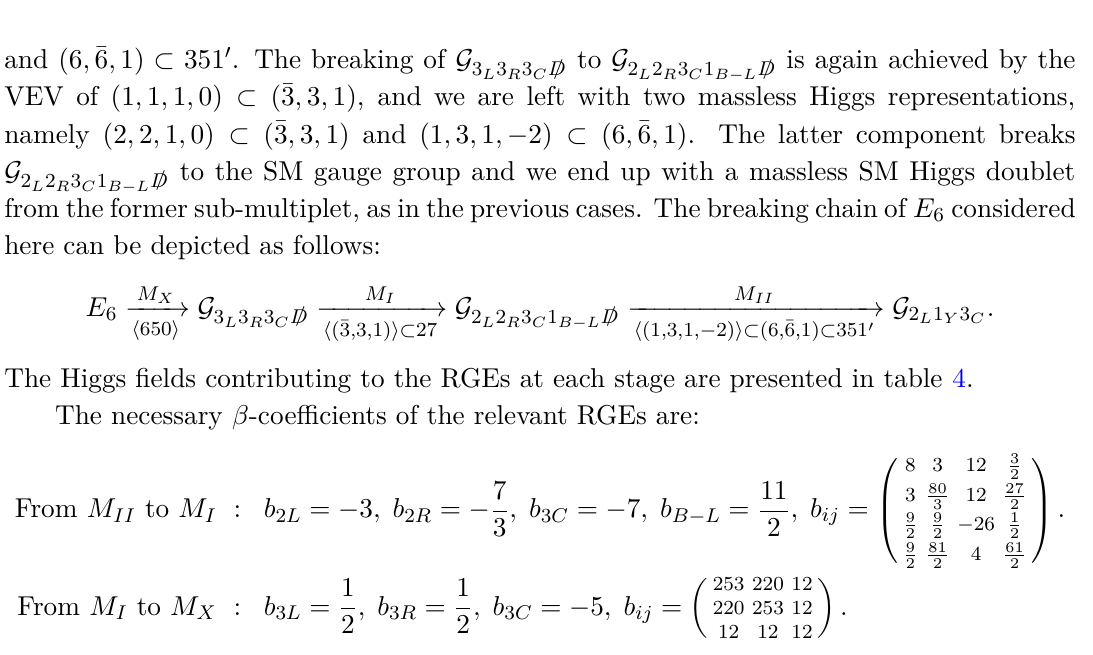
Table 4. Higgs representations that contribute to the RGEs at each stage of the symmetry breaking for the E model in section 6